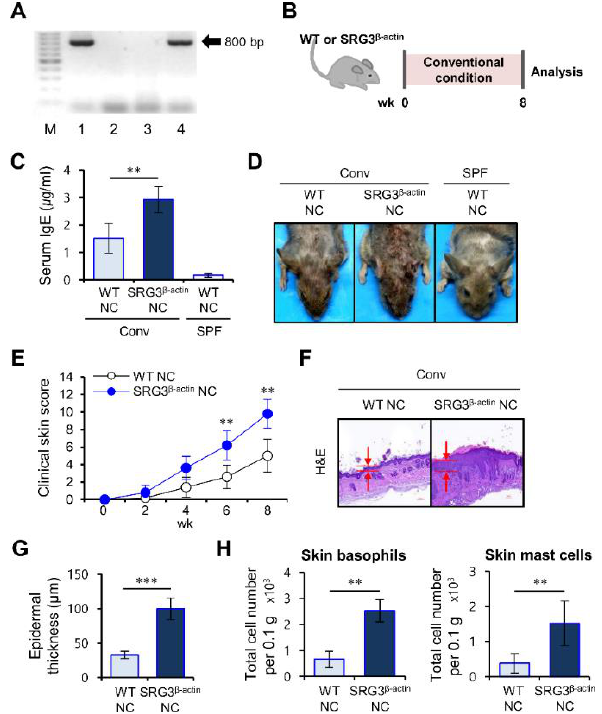
Figure 1. SWI3-related gene (SRG3) overexpression driven by the β-actin promoter exacerbates the severity of atopic dermatitis (AD) development in NC/Nga (NC) mice. ( A ) Genotyping of the SRG3 Tg gene by PCR analysis. SRG3 Tg gene PCR band sizes are 800 bp long. M: marker; Lane 1 (+): positive control (from SRG β-actin Tg B6); Lane 2 (−): negative control (from wild-type (WT) B6); Lane 3: SRG3 β-actin non-Tg NC; Lane 4: SRG3 β-actin Tg NC. ( B – H ) SRG3 β-actin NC and WT littermate NC mice